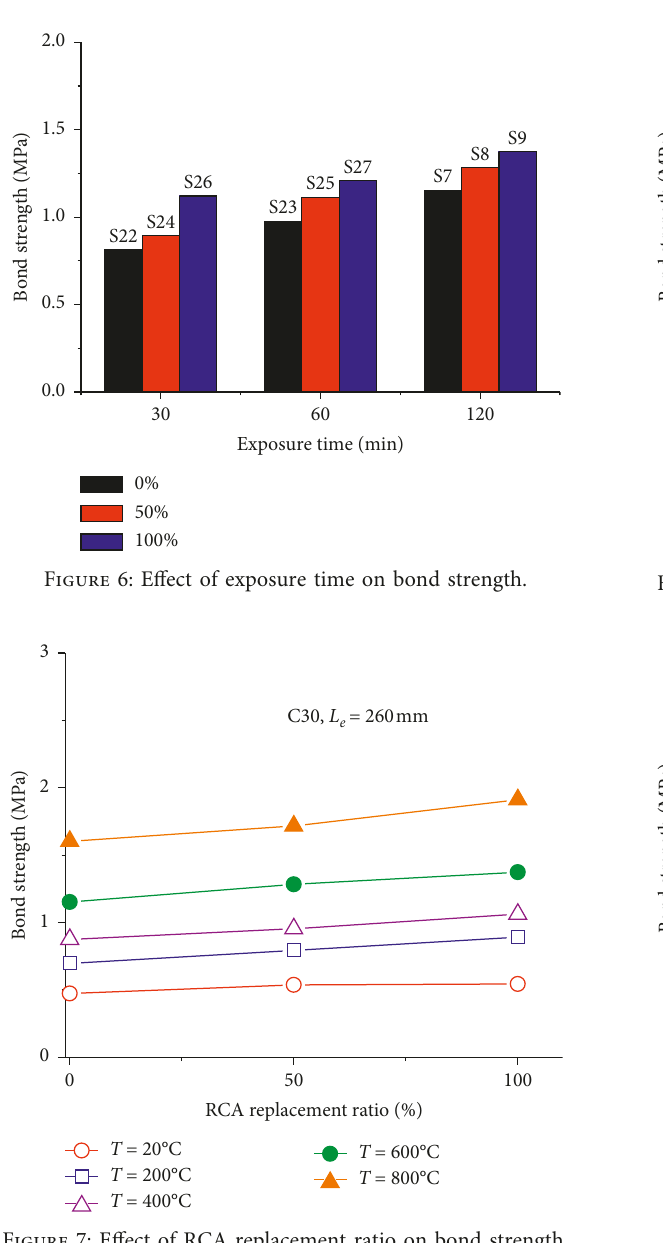
Figure 7: Effect of RCA replacement ratio on bond strength.